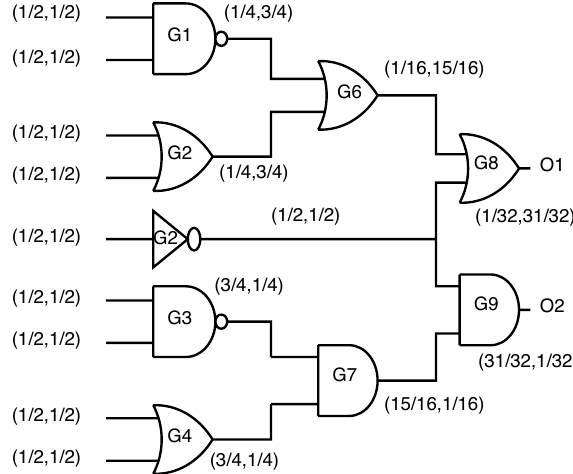
Figure 23. Output probability analysis using standard gates.